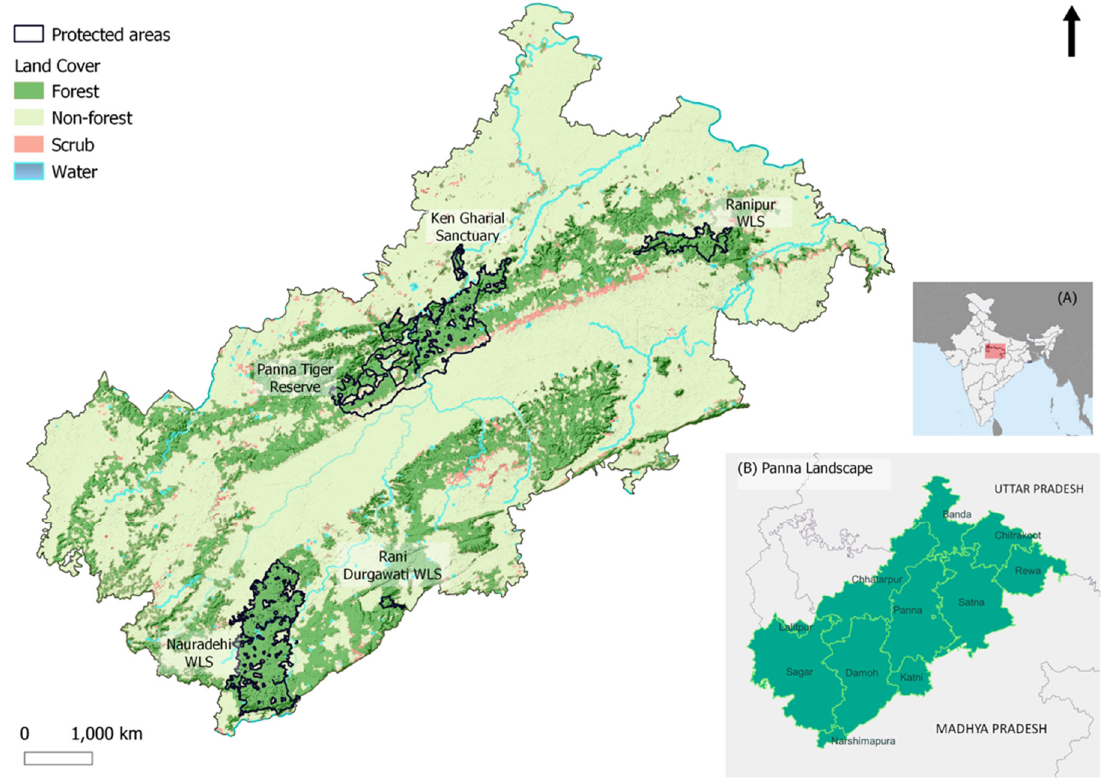
Figure 1. Location and extent of Greater Panna Landscape ( A ) in India, ( B ) districts (administrative units) of Madhya Pradesh and Uttar Pradesh that are part of Greater Panna Landscape. The main map shows major land cover classes (Forest Survey of India, 2014) and protected areas in the landscape. WLS indicates Wildlife Sanctuary.